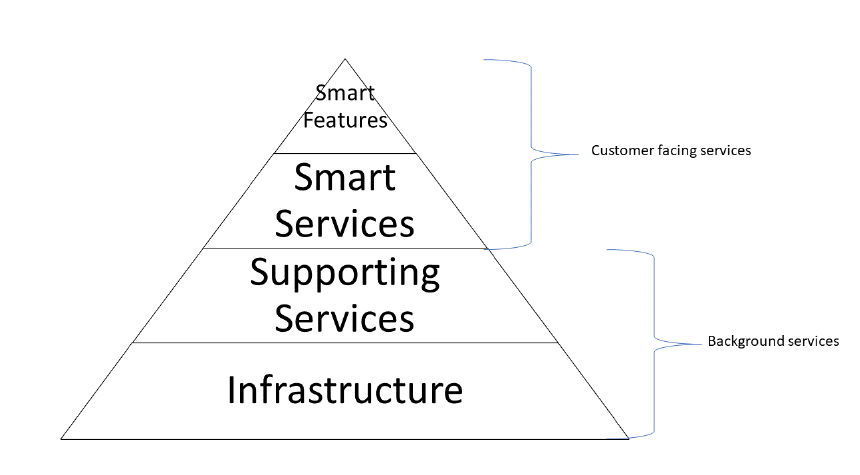
Figure 5. Structure of the Smart services. Source: author´s